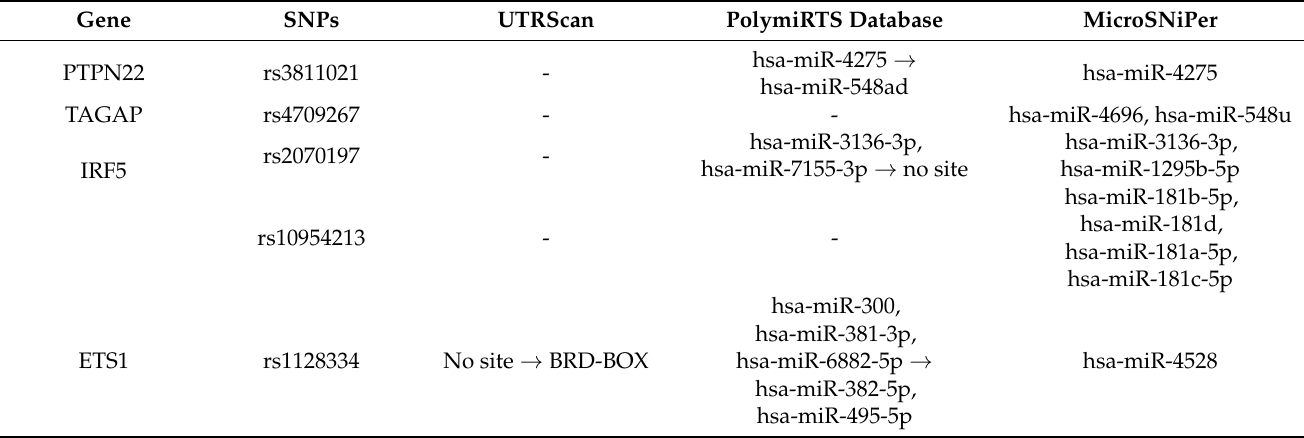
Table 10. UTR SNPs associated with RA and their predictive regulatory